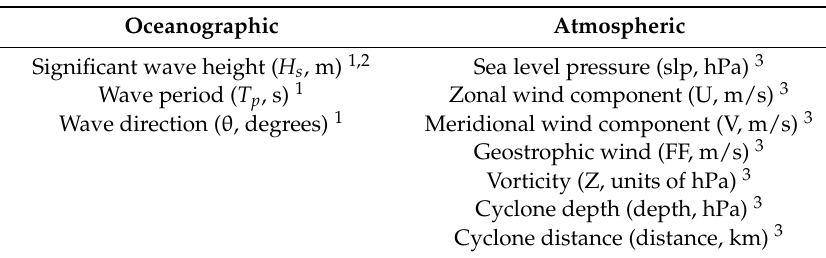
Table 1. Summary of the variables used in this